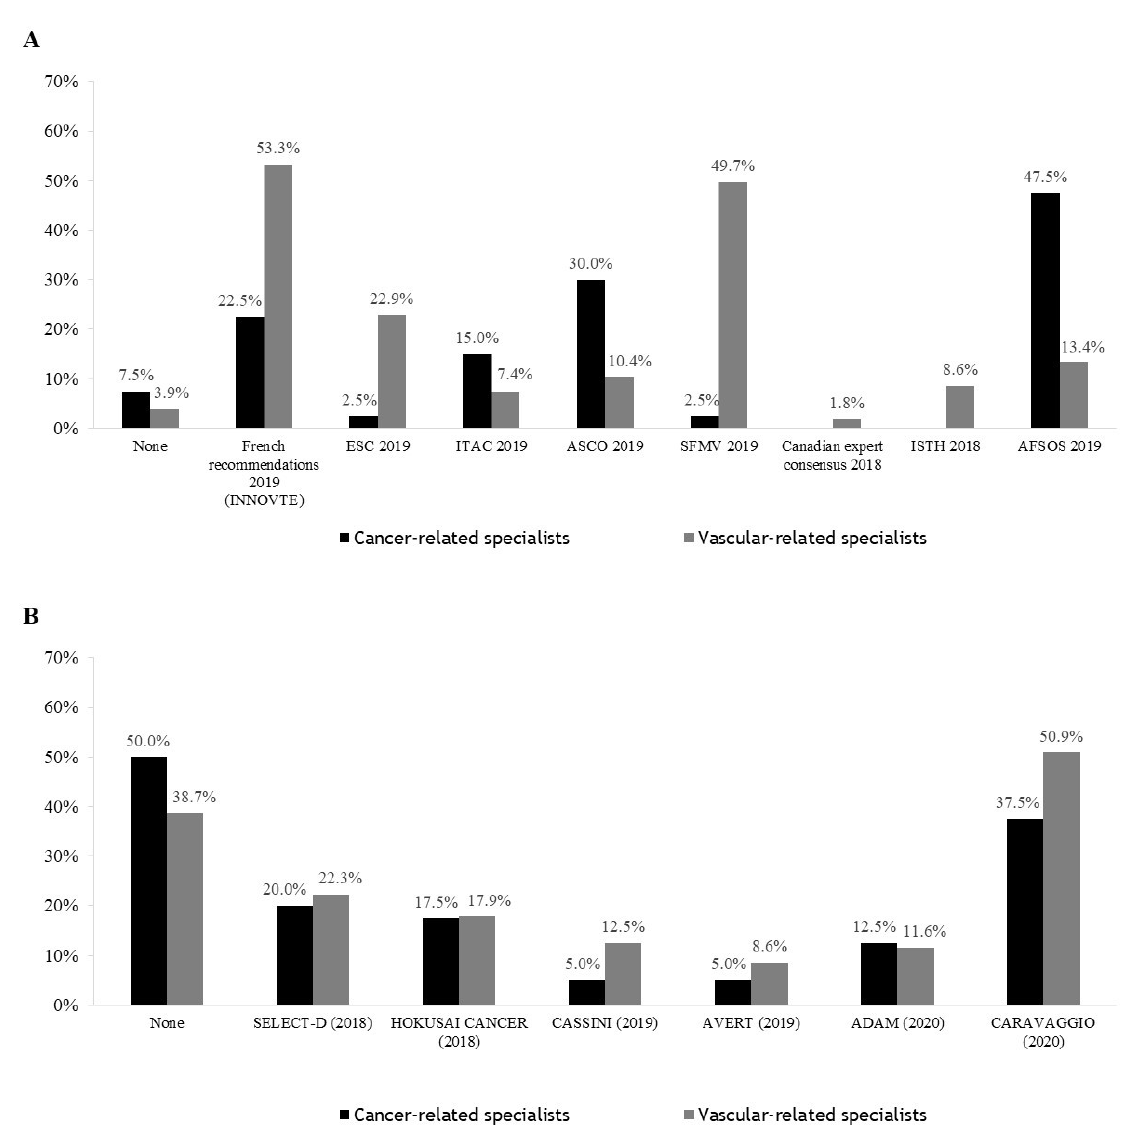
Figure 3. Comparisons of guidelines considered for practice in CAT management ( A ) and studies that have influenced practices ( B ) between cancer-related and vascular-related specialists.